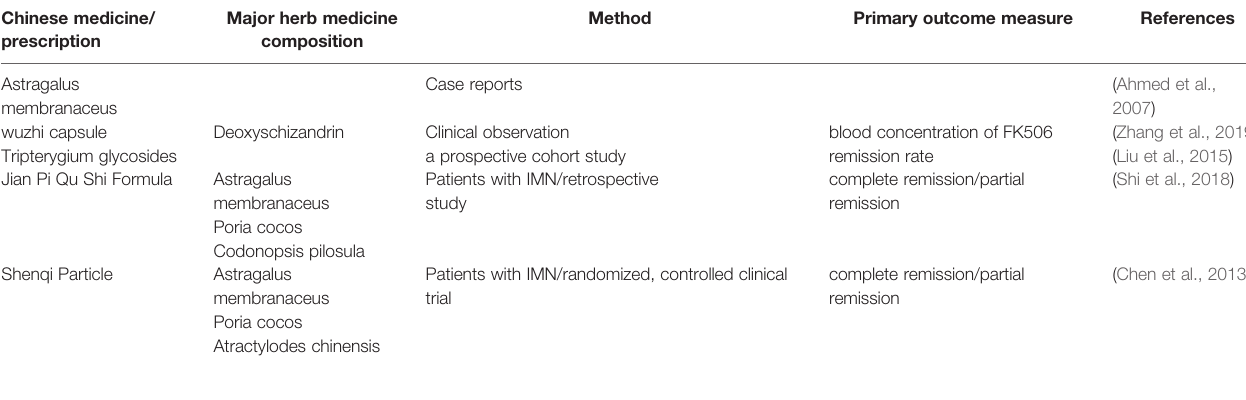
TABLE 1 | Chinese medicine treats membranous